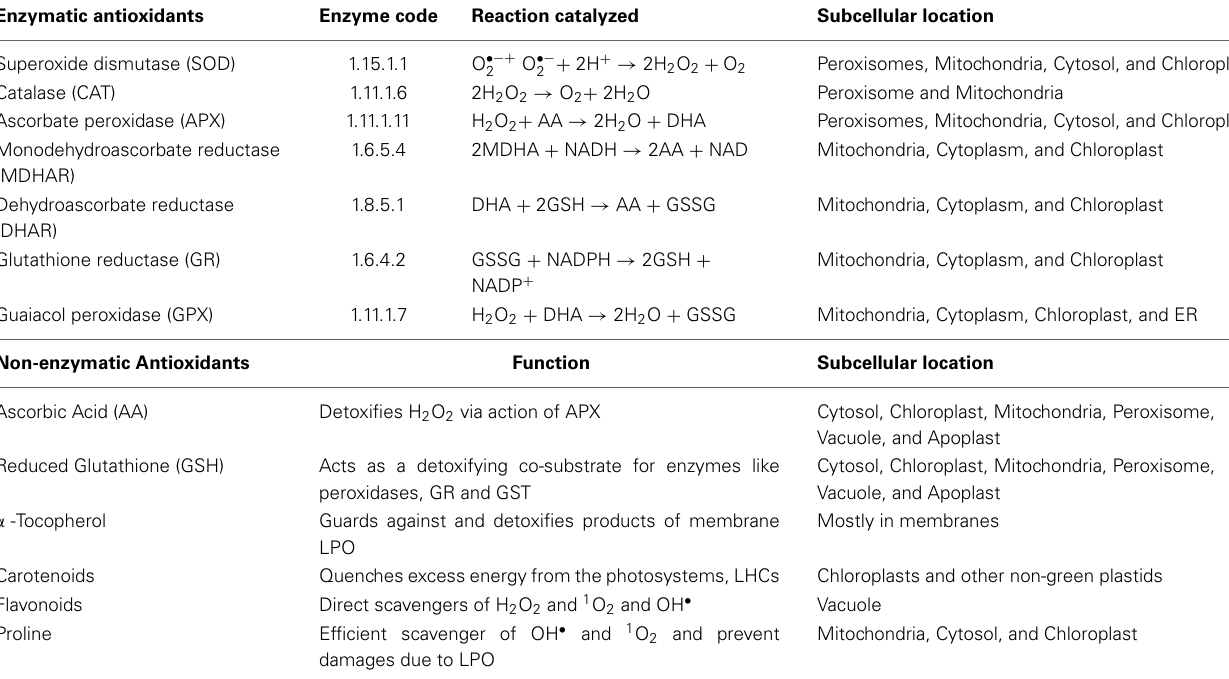
Table 2 | List of all the enzymatic and non-enzymatic antioxidants along with their functions and cellular localization. Enzymatic antioxidants Enzyme